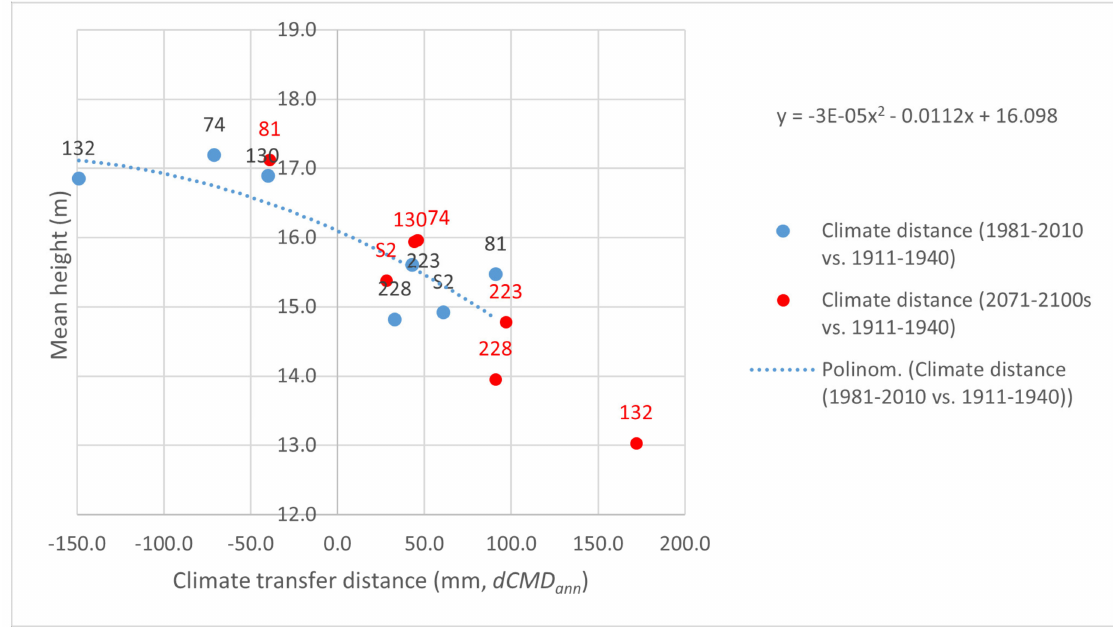
Figure 5. Comparison of current height at P í sek and estimated future mean height response to climatic change of silver fir populations at their original location of provenance. Their performance is compared under two climatic transfer situations, current heights at the test site (data measured in 2015, blue dots) and projected heights at origin in the climate period 2071–2100 (derived from ClimateEU , pathway RCP8.5, red dots). The transfer equation for current vs past climate was extrapolated for future data. The horizontal axis shows climate distances in dCMD units (mm precipitation deficit). For the sake of comparison, both current and future heights appear as the site index value for the age of 40 years, i.e., in